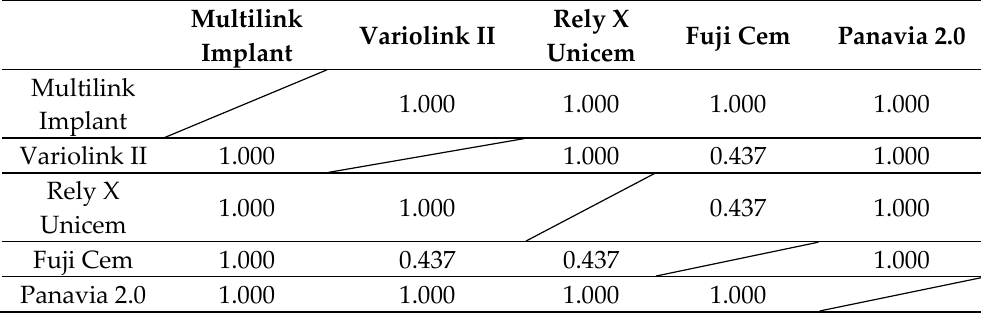
Materials 2022 , 15 , 6968